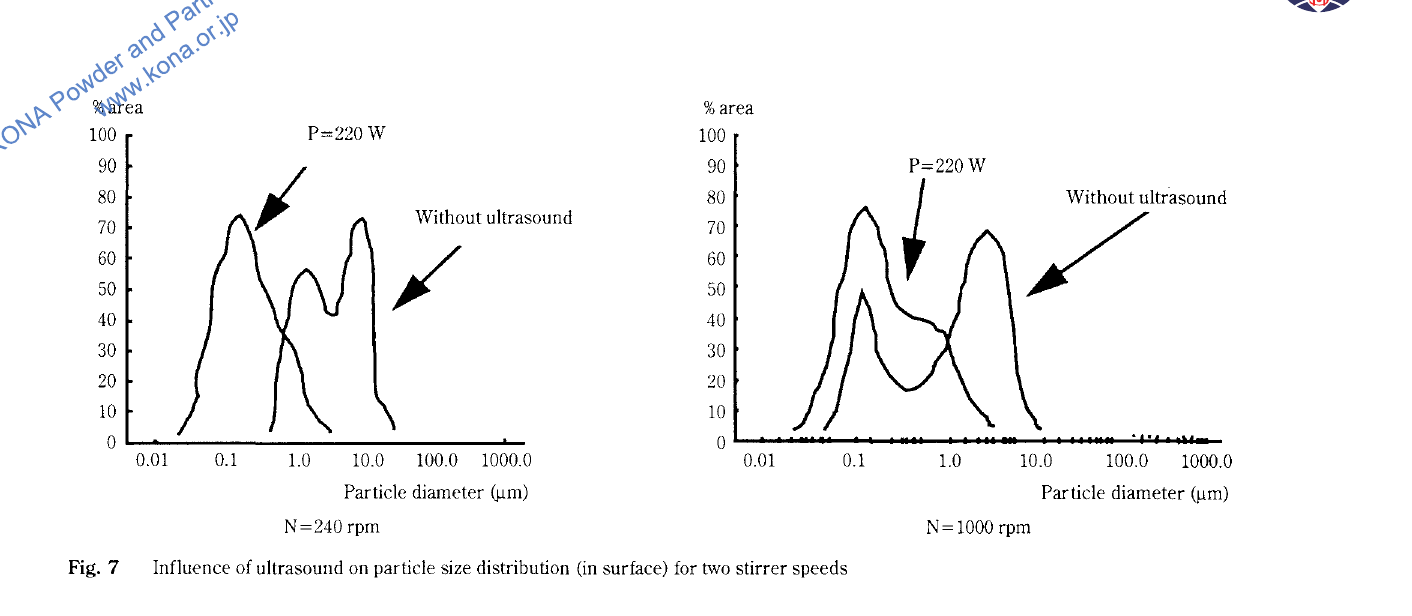
Influence of ultrasound on particle size distribution (in surface) for two stirrer speeds